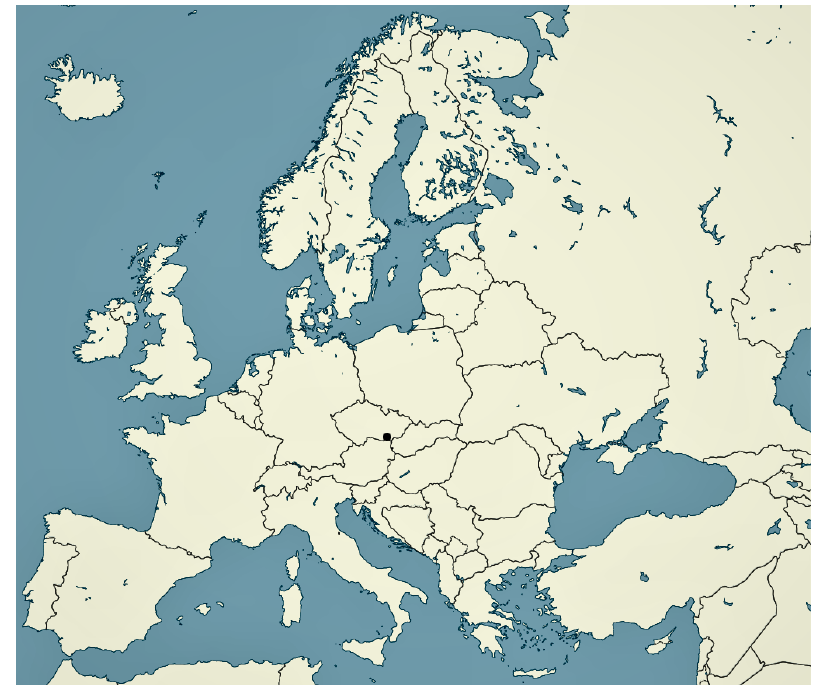
Figure 1. Location of the type locality of A. cerrina in the Czech Republic (black dot).